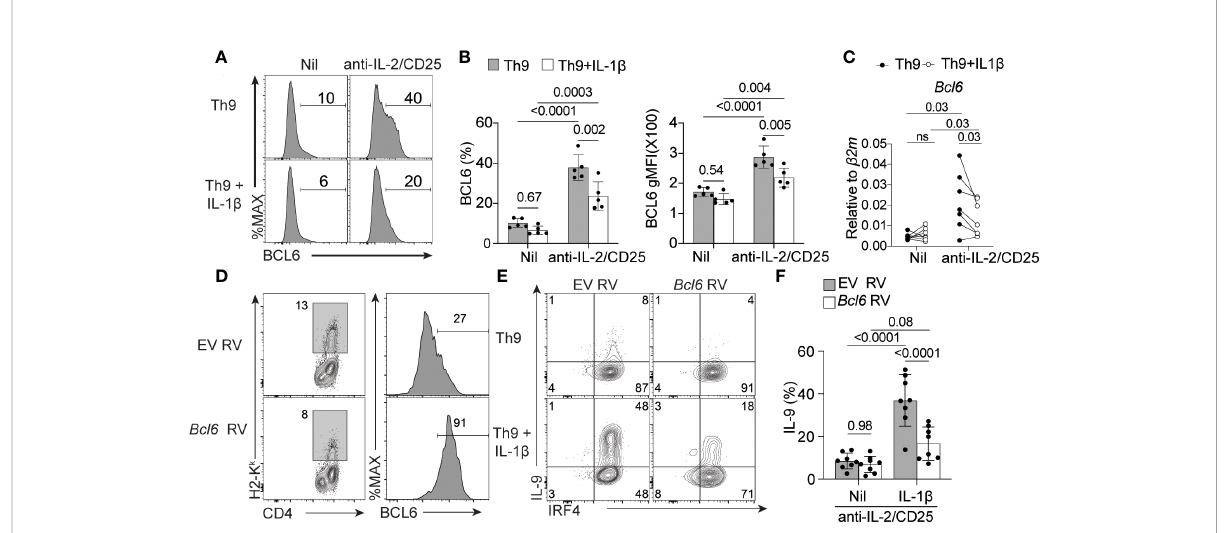
FIGURE 6 IL-1 b reduces the expression of BCL6 to rescue IL-9 production in IL-2-limiitng conditions. (A) Representative histograms of BCL6 expression in Th9 cells with and without IL-2 deprivation and with and without IL-1 b as determined by fl ow cytometry. (B) Quanti fi cation of %BCL6 + Th cells (left panel) and relative BCL6 protein expression (geometric mean fl uorescence intensity (MFI), right panel). (C) Bcl6 mRNA relative expression in Th9 cells cultured as in panel (A) . (D) Representative histograms depicting empty vector retrovirus (EV RV) or Bcl6 -expressing retrovirus ( Bcl6 RV) transduction ef fi ciency of Th9 cells cultured under IL-2 limiting conditions and associated BCL6 protein expression from transduced H2-K k+ cells). (E) Representative contour plots of intracellular IRF4 and IL-9 staining of IL-2-deprived Th9 cells in the presence or absence of IL-1 b that have been transduced with empty vector or Bcl6 -expressing retrovirus. (F) Quanti fi cation of data in panel (E) Data represent naïve T cell cultures from 5-8 mice per group from 2-3 individual experiments. Statistical signi fi cance ( p <0.05) was determined by one-way ANOVA. Error bars represent SD. ns, non-signi fi